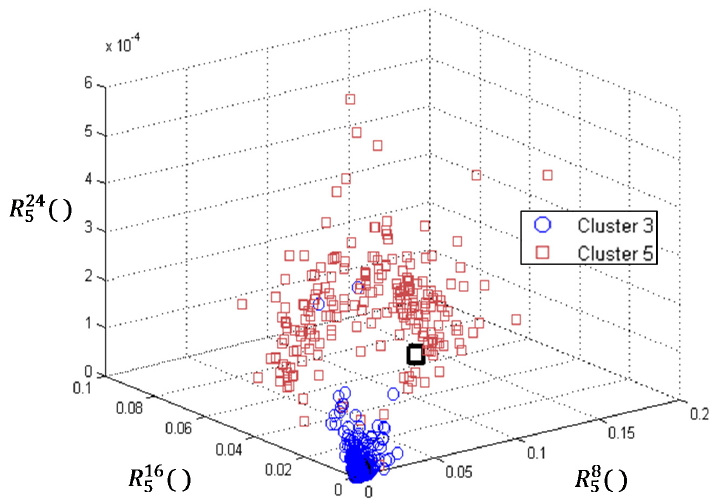
Figure 6. Visualization of feature vectors designated as cluster 3 and 5.